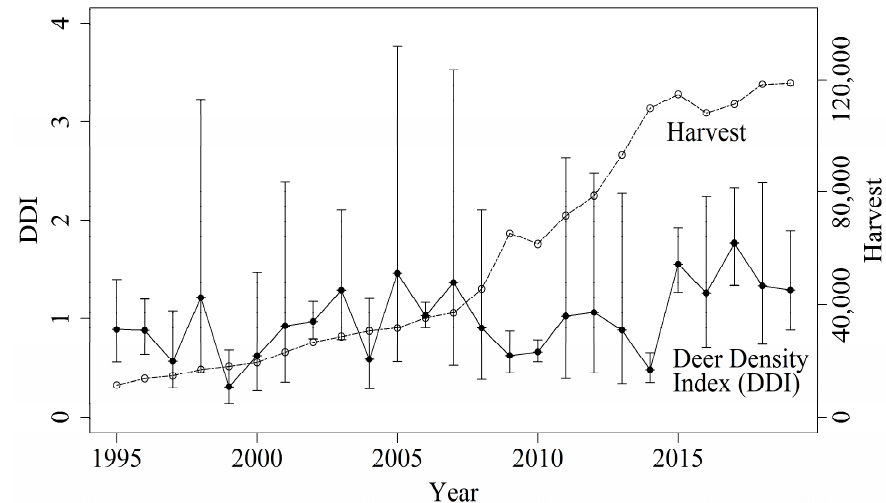
Figure 3. Annual deer density index (DDI) and harvests in the entire study area during the study period. DDI and error bars (95% CI) were estimated from the VAST model discussed in the text. In addition, DDIs ˆ D ( t , p ) were relatively stable in each prefecture throughout the study period (Figure 4). DDIs rapidly increased from 2014 to 2015 in Kumamoto, Miyazaki and Kagoshima prefectures, and the density appeared to remain high after 2015. However, once again, the confidence intervals were large, and the estimation accuracies were lower than they were before 2014.